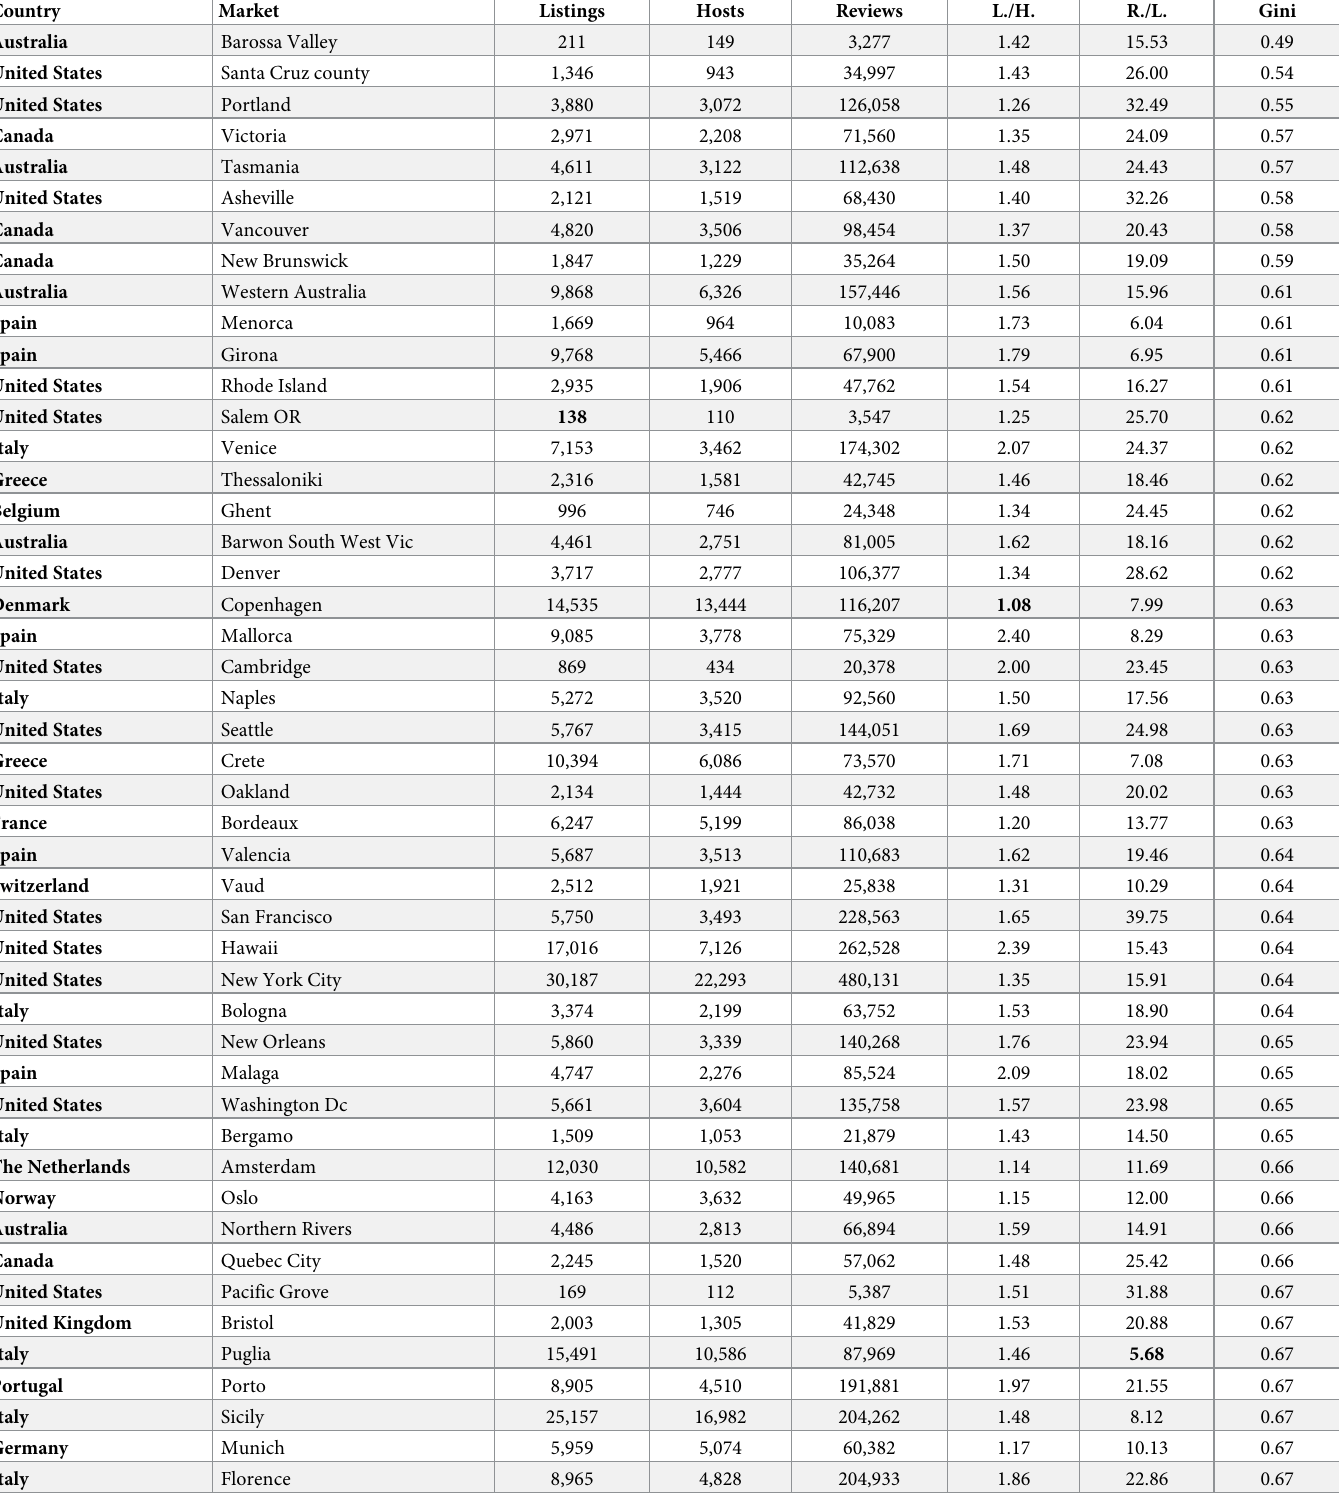
Table 1. The number of listings, hosts, reviews, and Gini coefficients for 2019 of the 97 cities included.